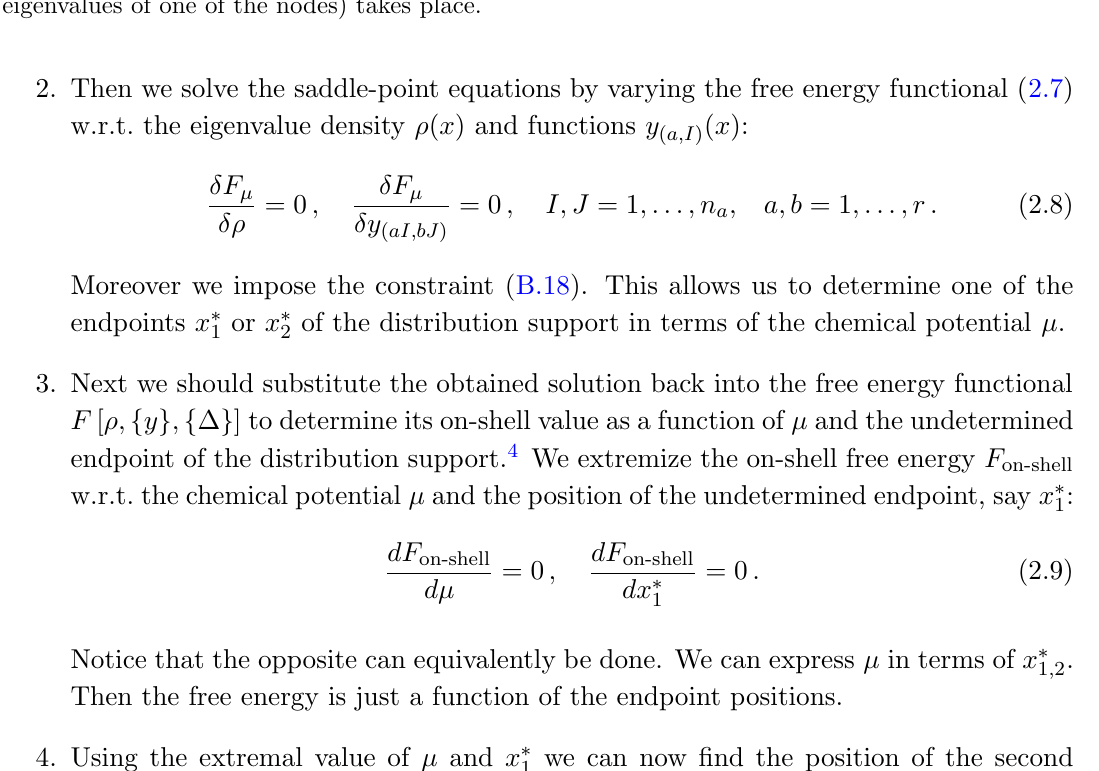
Figure 1 . Examples of the eigenvalue distributions for D 4 (left) and Laufer’s (right) theory (that we will study in section 3). In both plots the bifurcation of the orange cut (corresponding to the eigenvalues of one of the nodes) takes